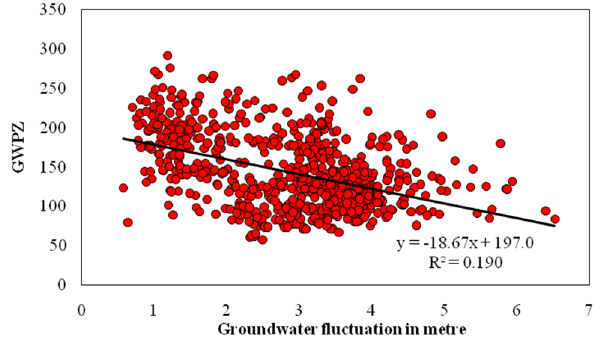
Fig. 17 Relationship between the water level fluctuation and the groundwater potential